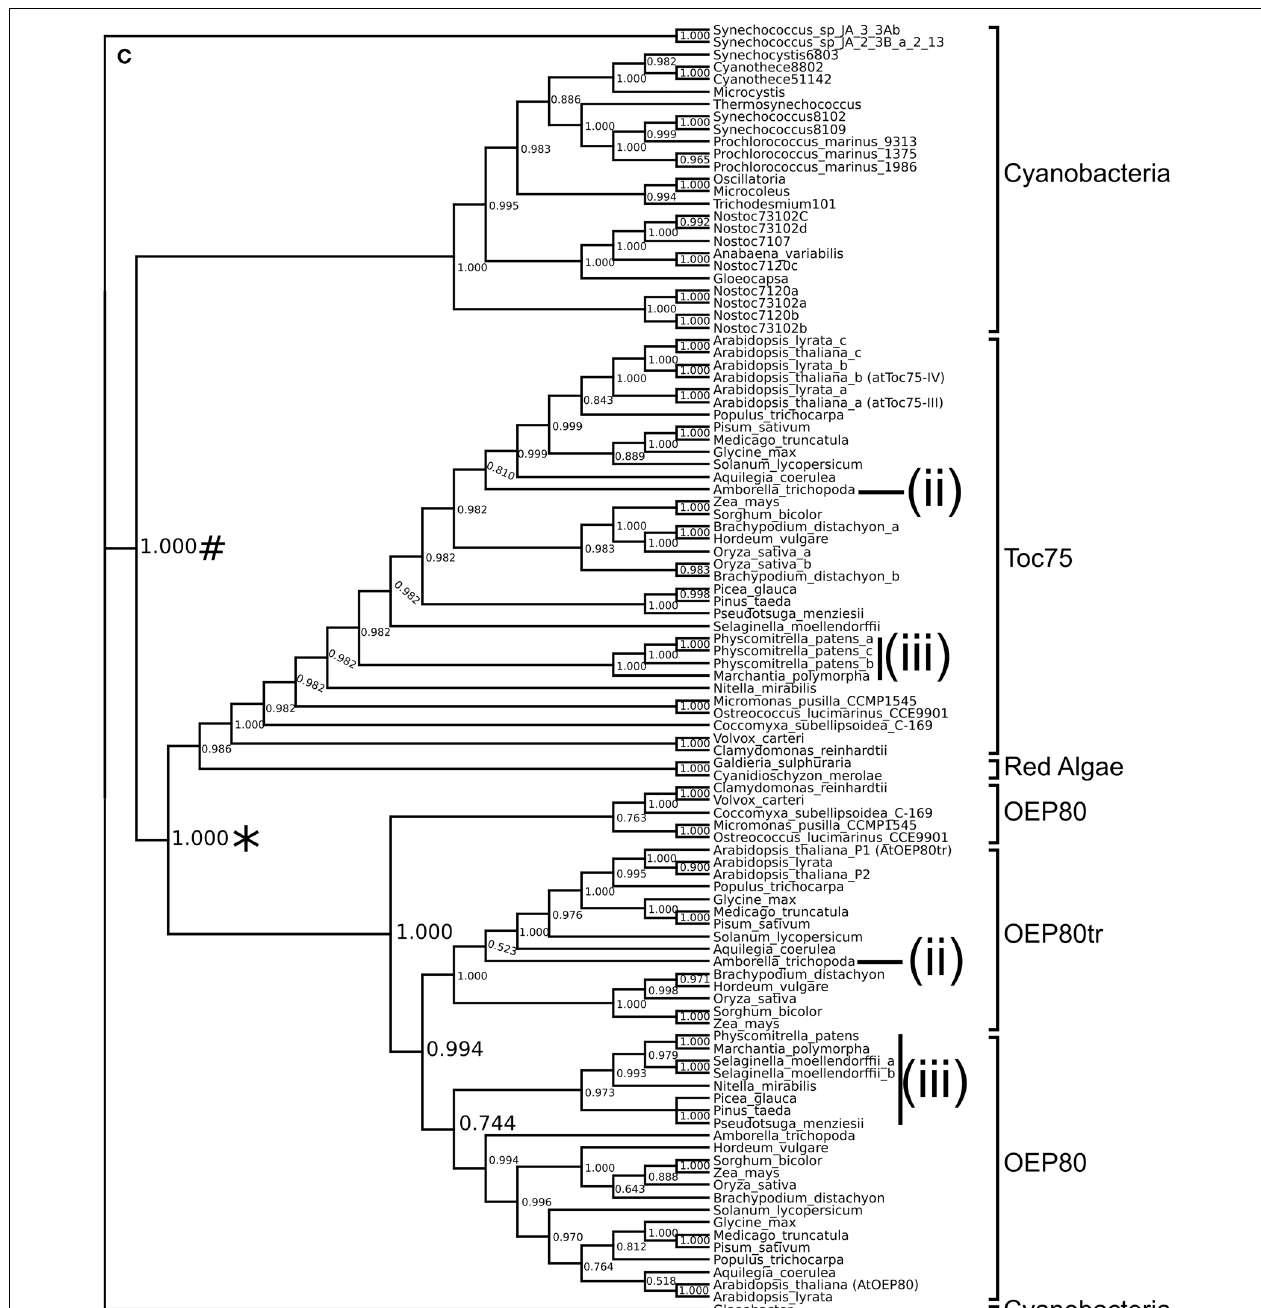
FIGURE 3 | Phylogenetic trees of Omp85 homologs. Sequences of chloroplast Omp85 homologs (Toc75, OEP80, and OEP80tr), cyanoOmp85, and outgroups from other bacteria and mitochondria were aligned with MAFFT. Phylogenetic inference was done using Bayesian inference. Each tree shown is the 50% majority-rule consensus tree generated for the 3002 trees produced by two runs of two million generations each, sampled every 1000 generations with a 25% burn in. (A) Consensus tree using an alignment of amino acid sequences corresponding to residues 438 to 818 of A. thaliana Toc75 with poorly aligned regions removed by Gblocks. Numbers at nodes